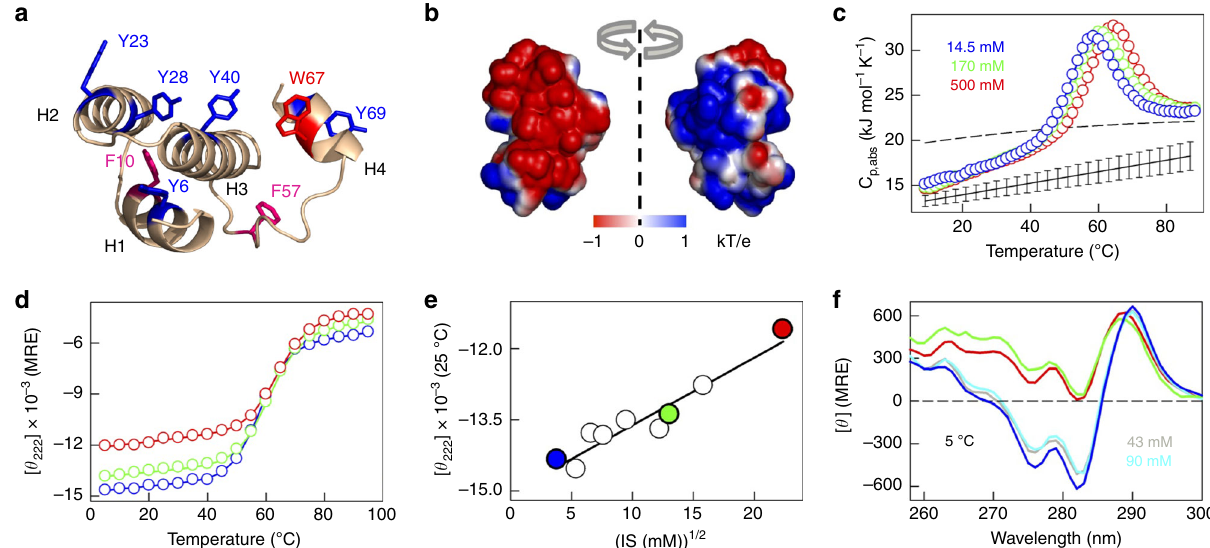
Fig. 1 Breakdown of structure-stability relationship. a The structure of Cnu indicating the four helices and aromatic residues. b Electrostatic potential map of Cnu highlighting the large asymmetry in charge distribution. c , d Absolute heat capacity pro fi les ( c ) and the far-UV CD monitored thermal unfolding curves ( d ) at the representative ionic strength conditions. e The degree of secondary structure (ordinate) as a function of ionic strength at 25 °C (abscissa). The three representative conditions are marked in blue (14.5 mM), green (170 mM), and red (500 mM), respectively. Additional spectra were acquired at various intermediate ionic strengths spanning the representative conditions (open circles). f Near-UV CD spectra at 5 °C display signi fi cant tertiary structural differences at low ionic strength (<100 mM) compared to high IS conditions. Source data are provided as a Source Data fi